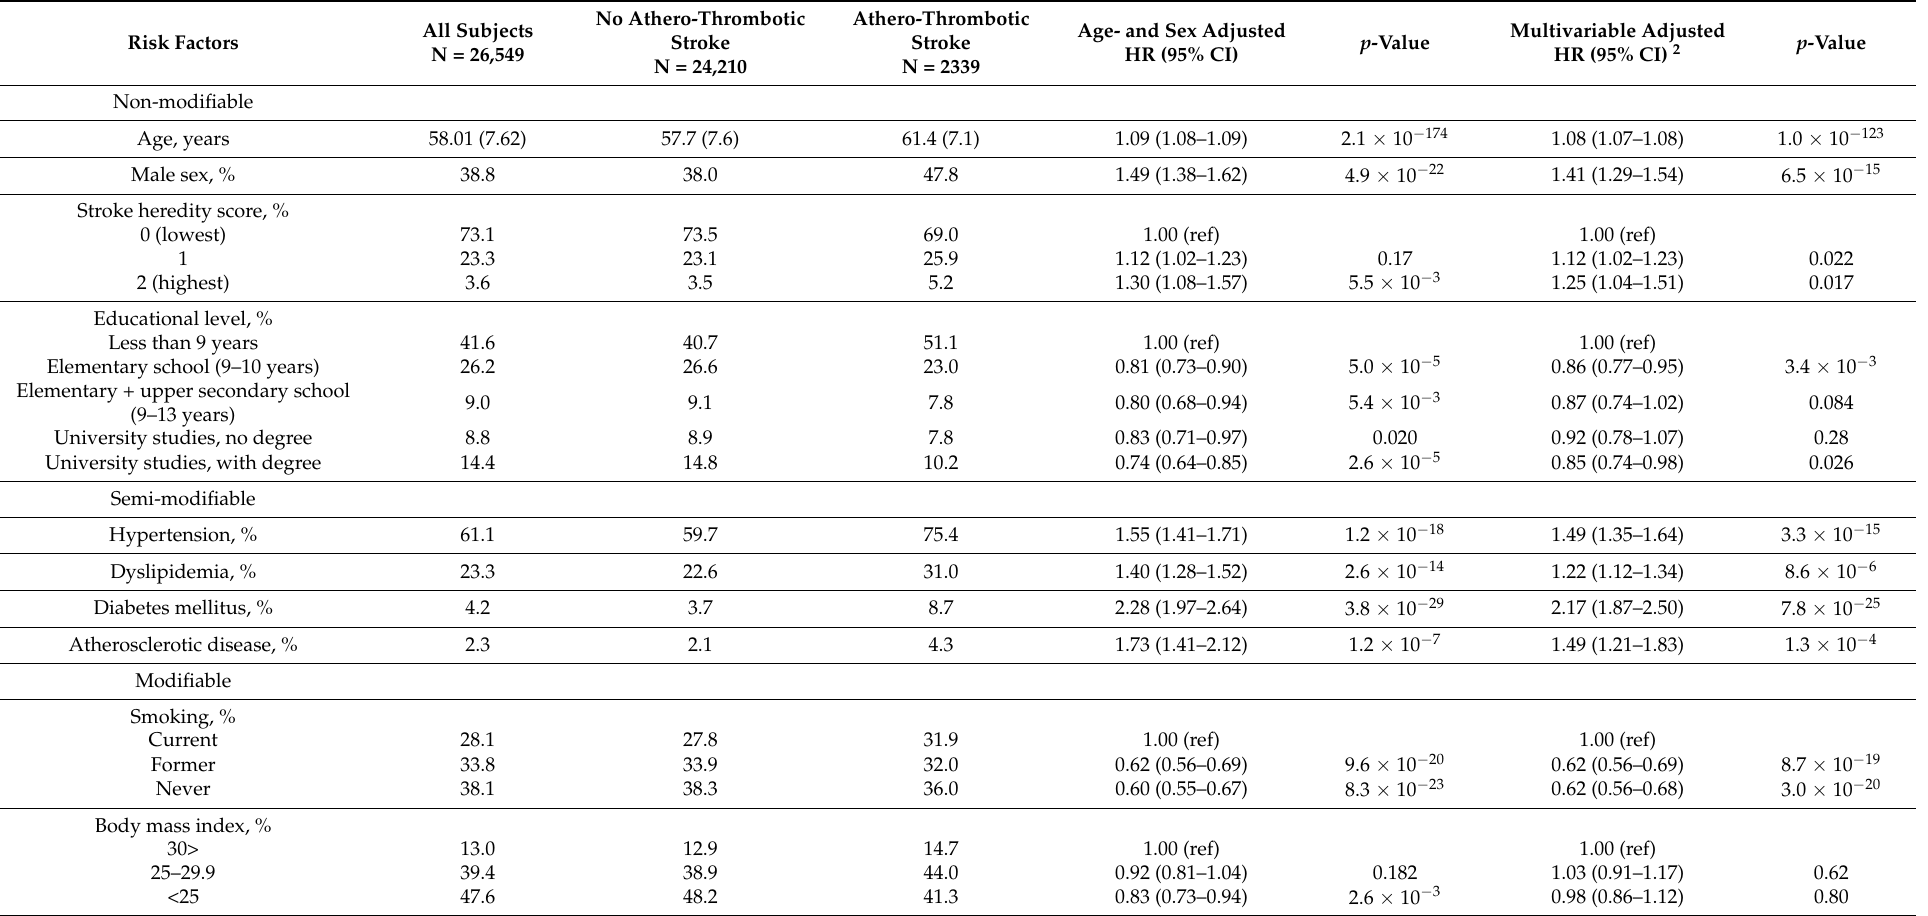
Table 1. Non-modifiable, semi-modifiable, and modifiable risk factors 1 in relation to incident atherothrombotic ischemic stroke among subjects of the Malmö Diet and Cancer Study (N = 26,549). Hazard ratios (HR) and 95% confidence intervals from Cox proportional hazards regression